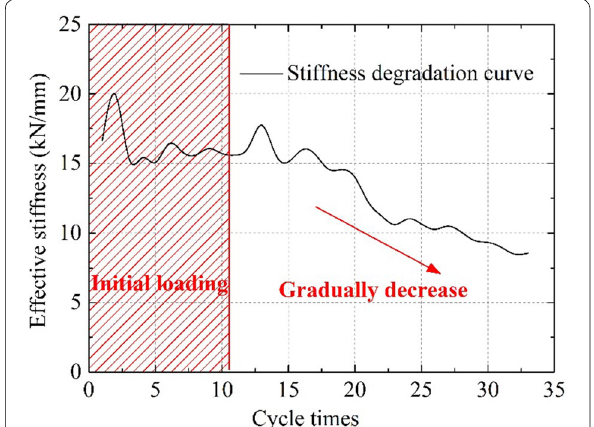
Figure 8 is the story load–story displacement hysteretic curve and skeleton curve of the steel–bamboo SI sys- tem test specimen. Because the slight rigid body rota- tion occurs during the test, the story displacement is